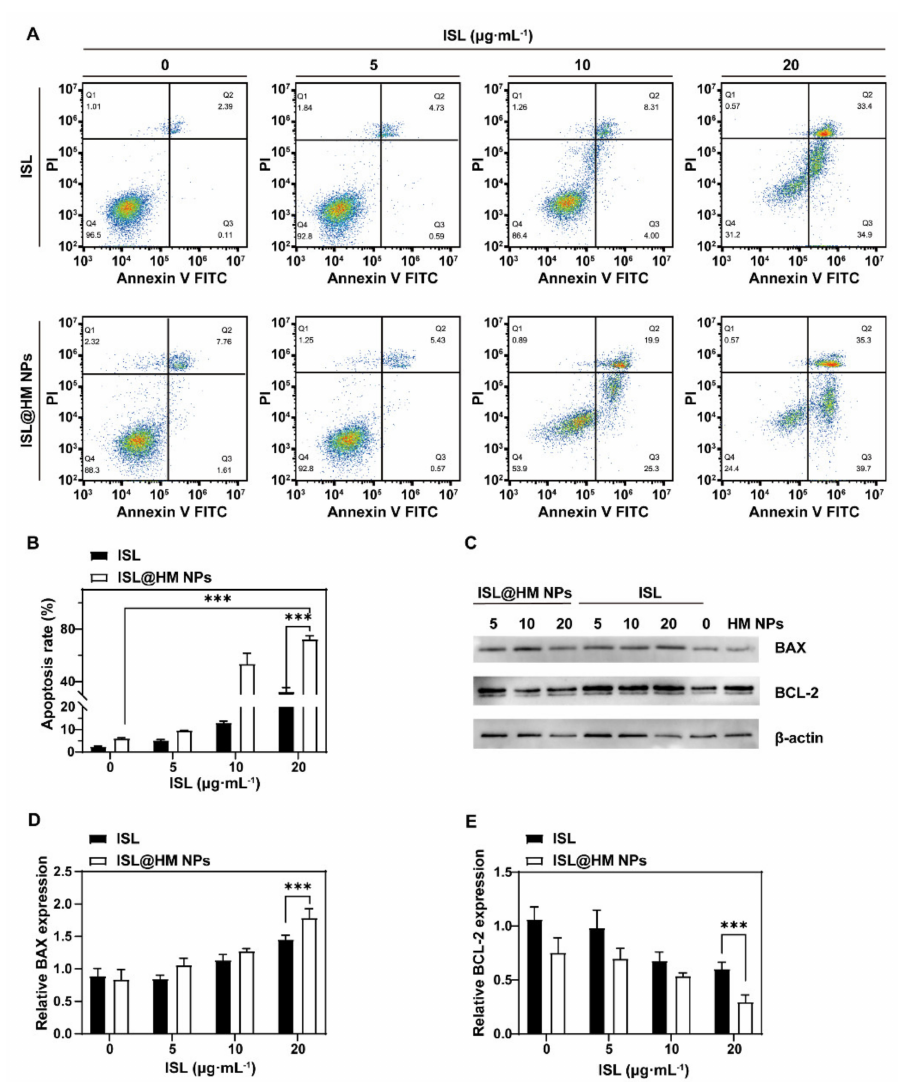
Figure 5. Annexin V − FITC/PI apoptosis assay ( A ) and quantitative analysis ( B ) of U251 cells after different treatments. Western blotting analysis ( C ) and quantitative analysis ( D , E ) of Bcl − 2 and BAX expression in U251 cells after different treatments. ( n = 3; mean ± s.d. *** p < 0.001, as determined by unpaired, two − tailed Student’s t -tests. n refers to biological